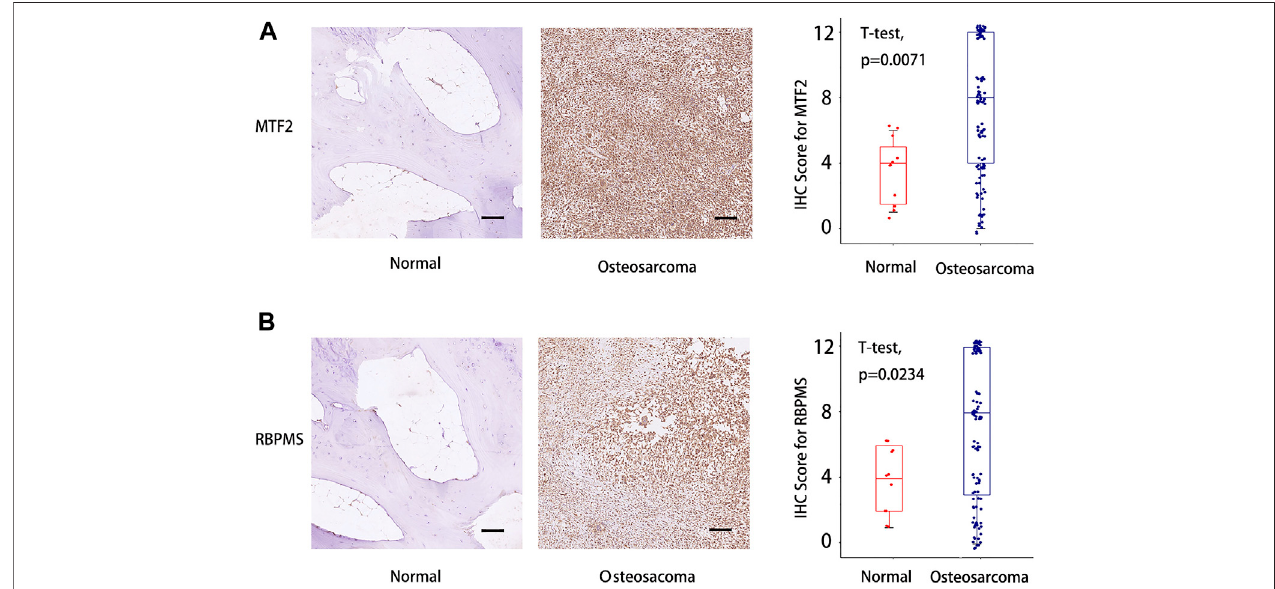
FIGURE 8 | IHC score difference analysis for MTF2 and RBPMS in osteosarcoma patients. (A) IHC score analysis for MTF2. (B) IHC score analysis for RBPMS. Scale bar = 100 um. IHC, immunohistochemistry. Supplementary Figure S1 The association between the expression of fi ve TcoF-related genes ( LMO2 , MAML3 , MTF2 , RBPMS , and SIRT1 ) in the risk model and immune cell in fi